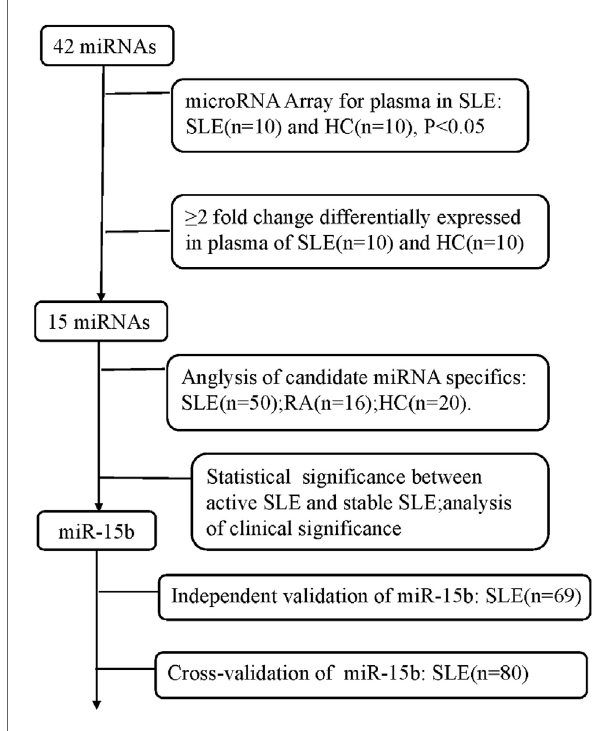
FigUre 1 | A flowchart of the study